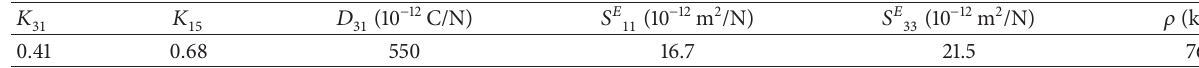
Table 2: PZT5H properties (plates).